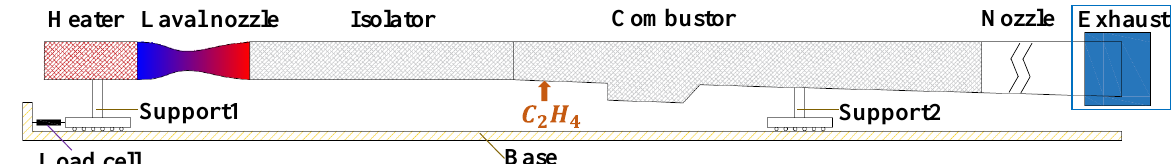
Figure 1. Schematic diagram of direct-connected test.